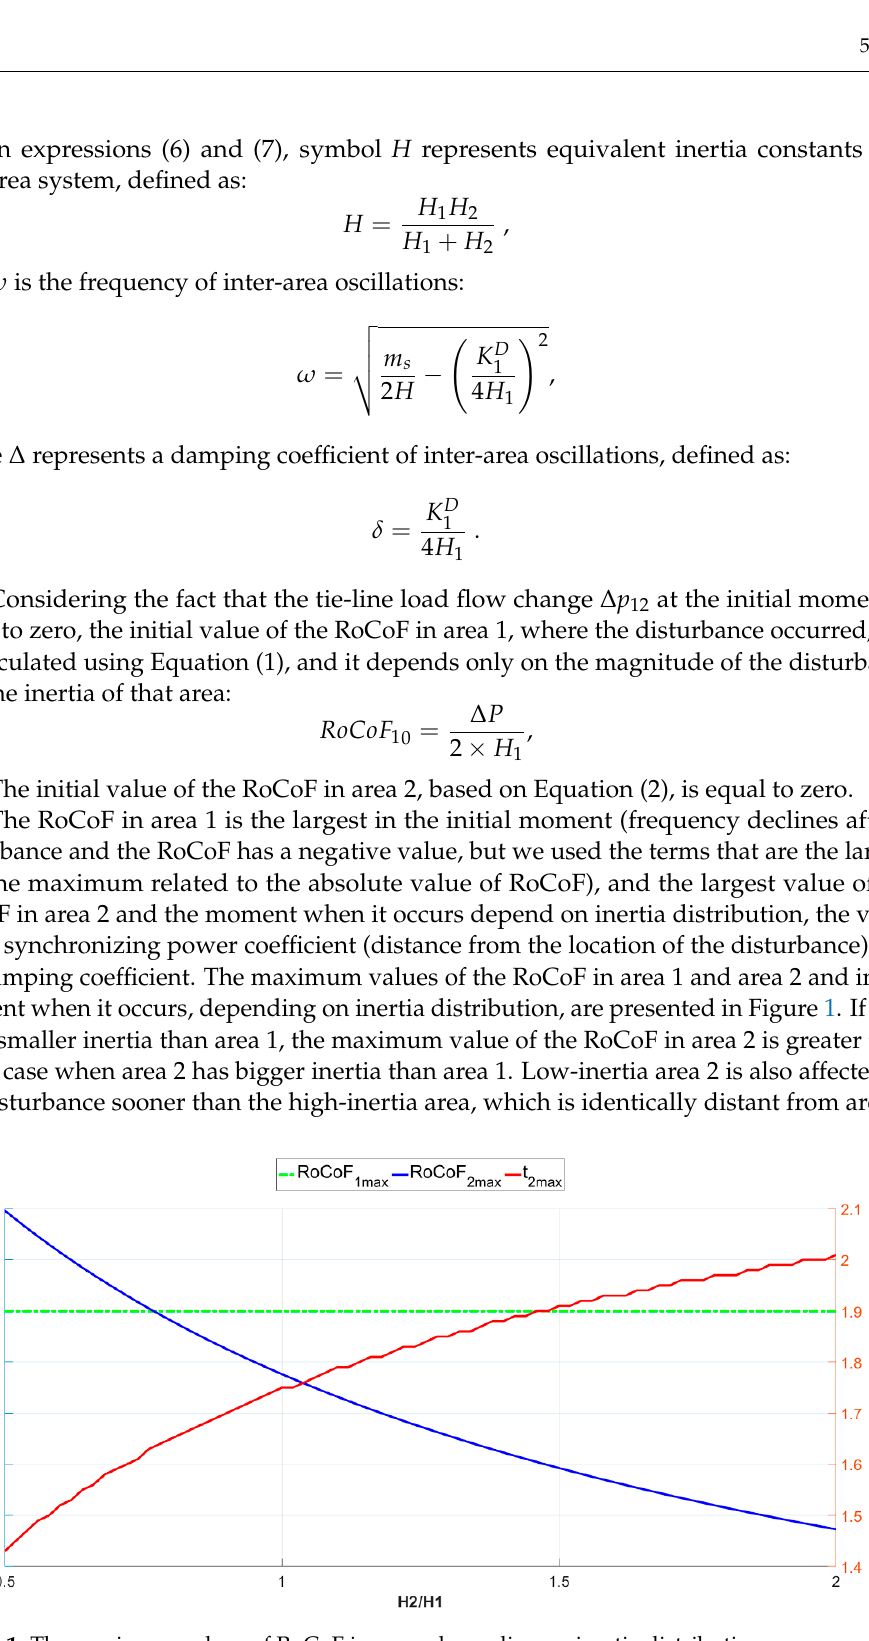
Figure 1. The maximum values of RoCoF in areas depending on inertia distribution.